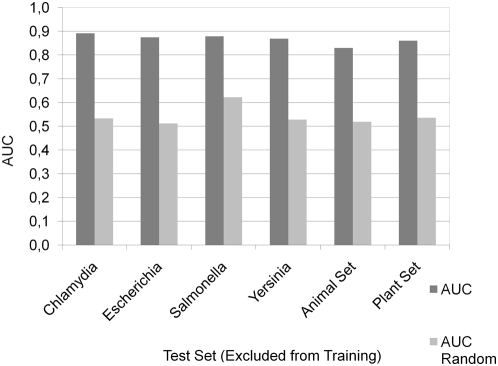
Taxonomic universality of the signal.The y-axis denotes the achieved AUC value of EffectiveT3 when trained without the positive and negative samples from the taxonomic group denoted at the bottom of the x-axis and tested against this set. The performance on a randomly chosen set of positives and negatives having the same taxonomic composition is given for comparison.